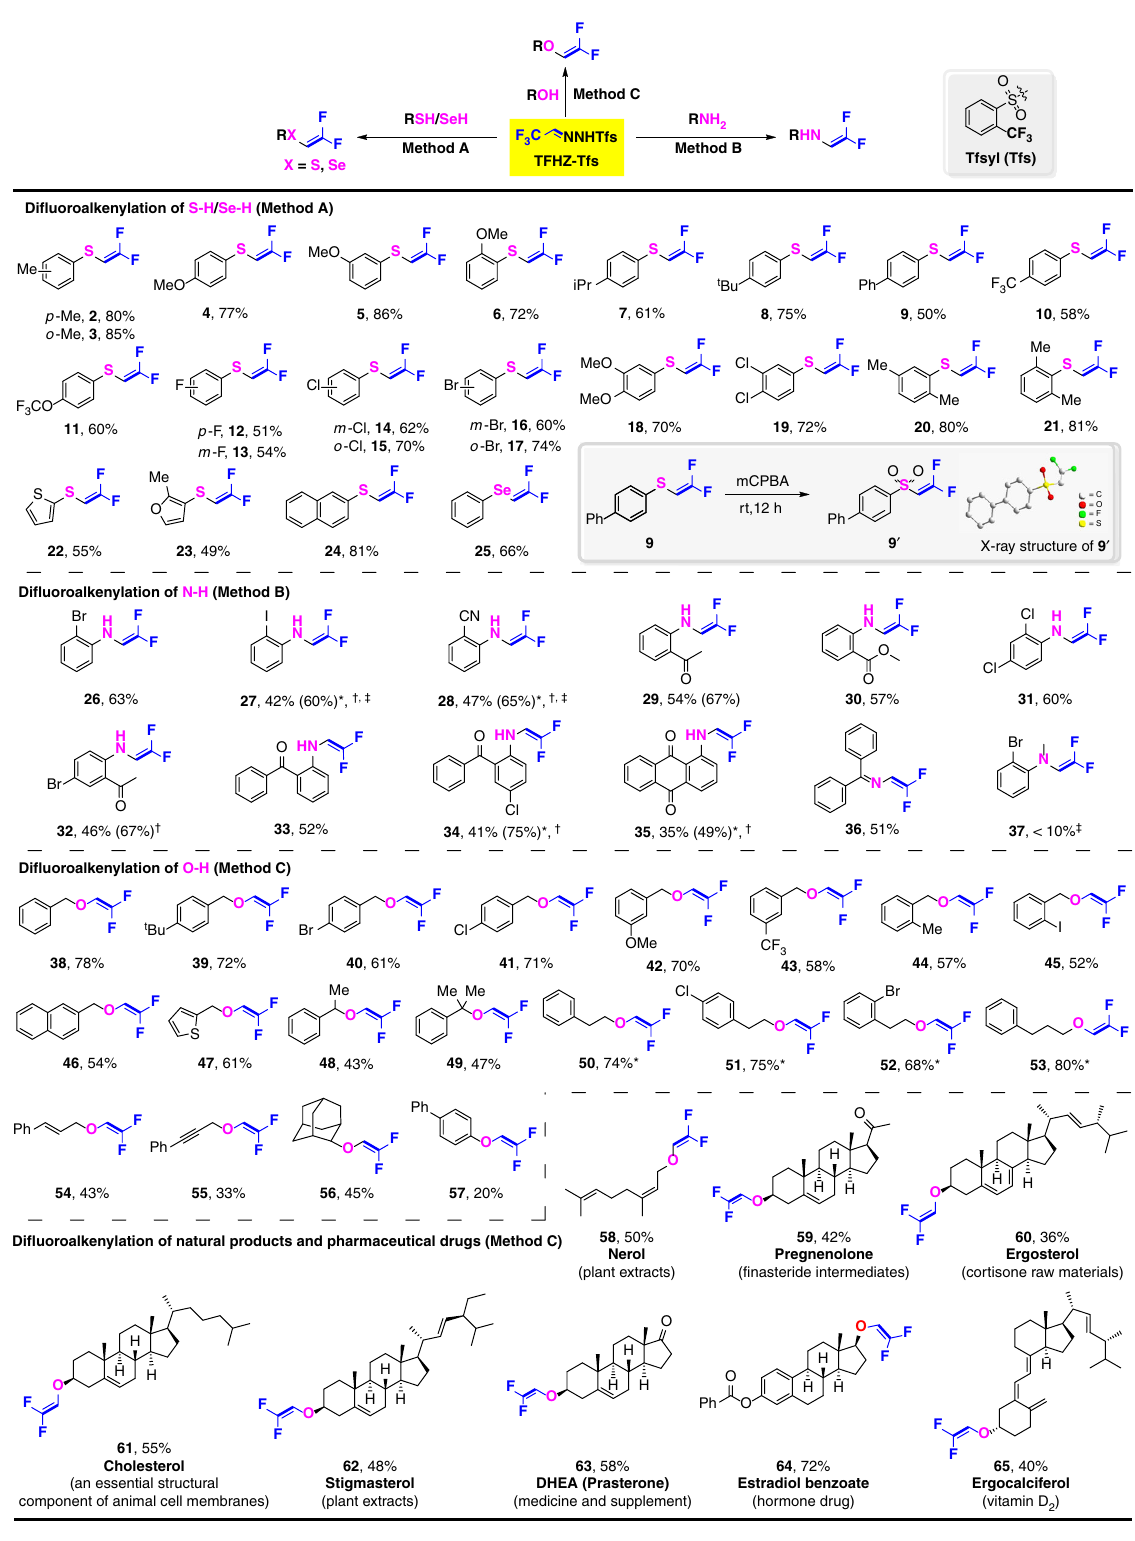
Fig. 3 Scope of gem -di fl uoroalkenylation of X – H (X = N, O, S, Se). Reaction conditions: Method A: thiophenol (0.3 mmol), TFHZ-Tfs (0.6 mmol), Fe[P2] (1 mol%), SDBS (30 mol%), KOH (aq.)/DCM (5:1), air, 40 °C, 18 h. Method B: amine (0.3 mmol), TFHZ-Tfs (0.6 mmol), Cu(OTf) 2 (20 mol%), LiO t Bu (4 equiv), DCE: toluene (3:1), Ar, 40 °C, 24 h. Method C: TFHZ-Tfs (1.0 mmol), NaH (4 equiv) and DCE (8.0 mL) were stirred at rt for 1 h under Ar, then CuBr (30 mol%), alcohol (0.5 mmol), and LiO t Bu (1 equiv) were added and the mixture was stirred at 40 °C under Ar for 24 h. *Reaction performed for 30 h. † Number in parentheses is the yield based on recovered starting material (brsm). ‡ The yield was determined by 1 H NMR spectroscopic analysis with CH 2 Br 2 as an internal standard